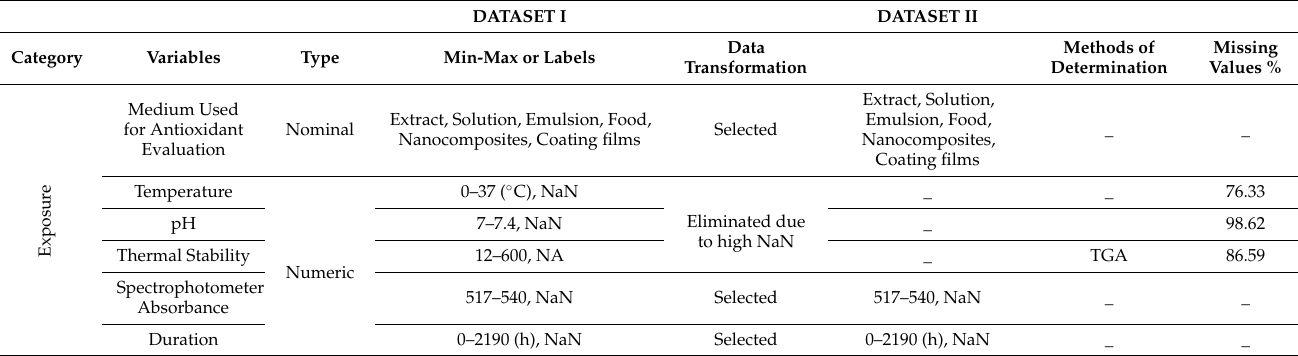
Figure 2. The internal model validation curve of RF model for the training score and the cross-vali- dation score. x-axis represents the hyperparameter of the tress depth, y-axis represents the score (accuracy) of the model. Depicted in Figure 3are the prediction error of the predicted values against the actual values. It shows that the predicted values produced by our model (0.83) are close to the observed targets from the dataset. In regression models, prediction error measures how effectively the model predicts the response variable and as can be seen, the predicted val- ues are relatively close to the actual values.